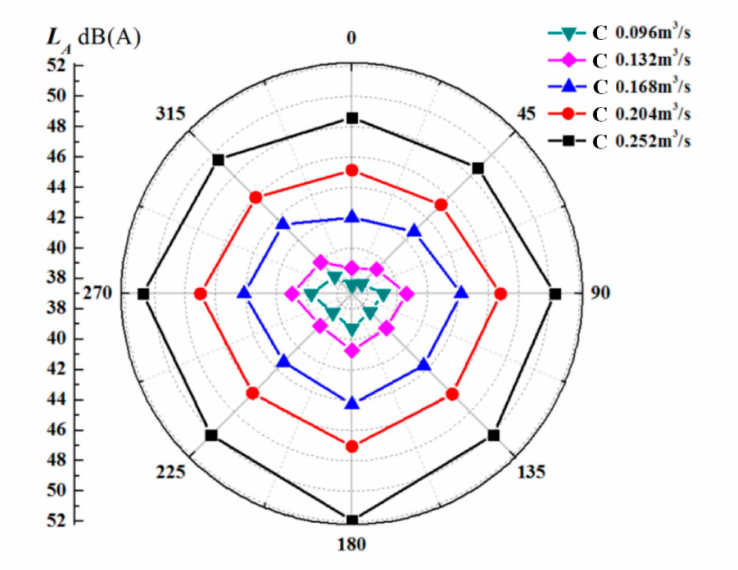
Figure 7. C blade models with the different outlet noise distribution of the flow at 1000